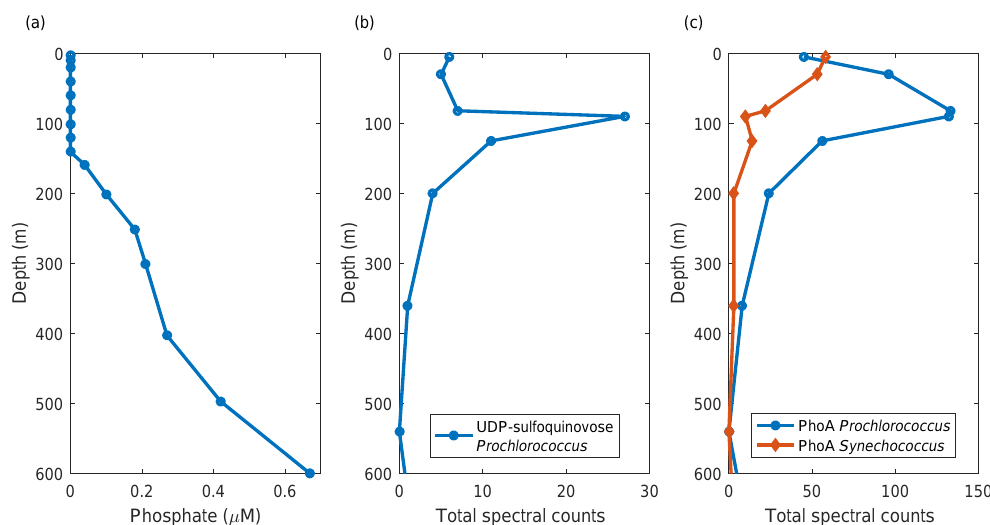
Figure 8. Profiles of (a) phosphate, (b) UDP-sulfoquinovose enyzme involved in sulfolipid biosynthesis, and (c) alkaline phosphatase en- zymes (PhoA isoform) at the BATS station in April 2015 from the marine cyanobacteria Prochlorococcus and Synechococcus as determined by global metaproteomic analyses. Proteins are in units of unnormalized spectral counts. PhoA is typically considered a zinc enzyme in model terrestrial organisms, but has been found to be a Co enzyme in a hydrothermal bacterium.